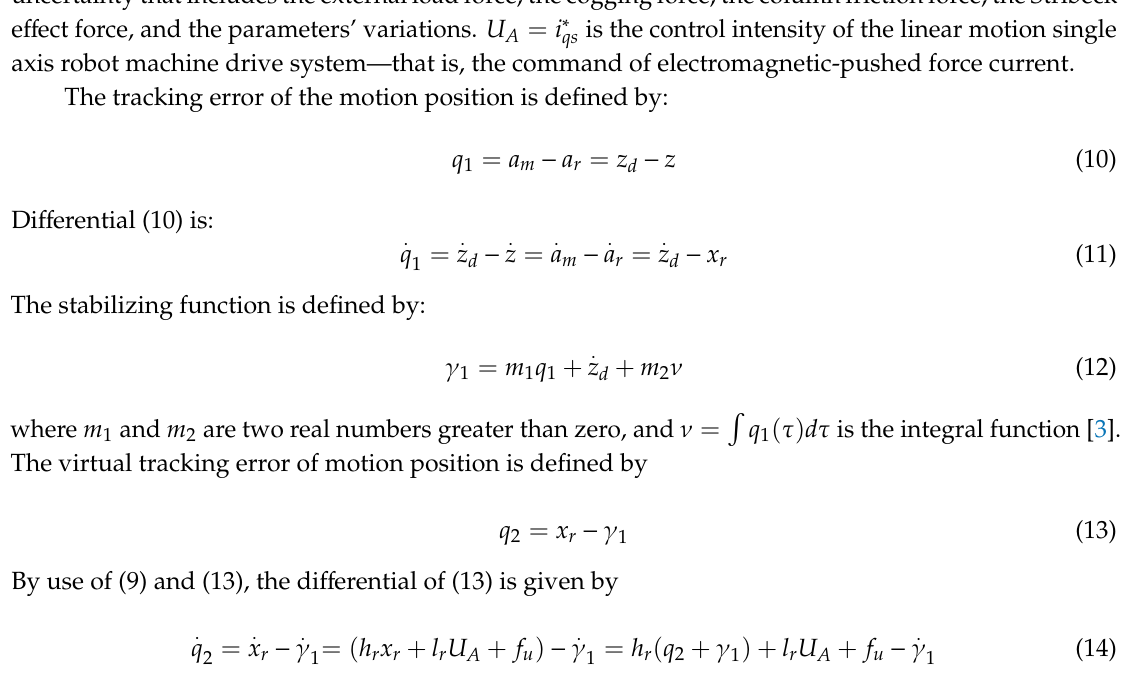
Figure 2. Simplified block diagram of linear motion single axis robot machine drive system.